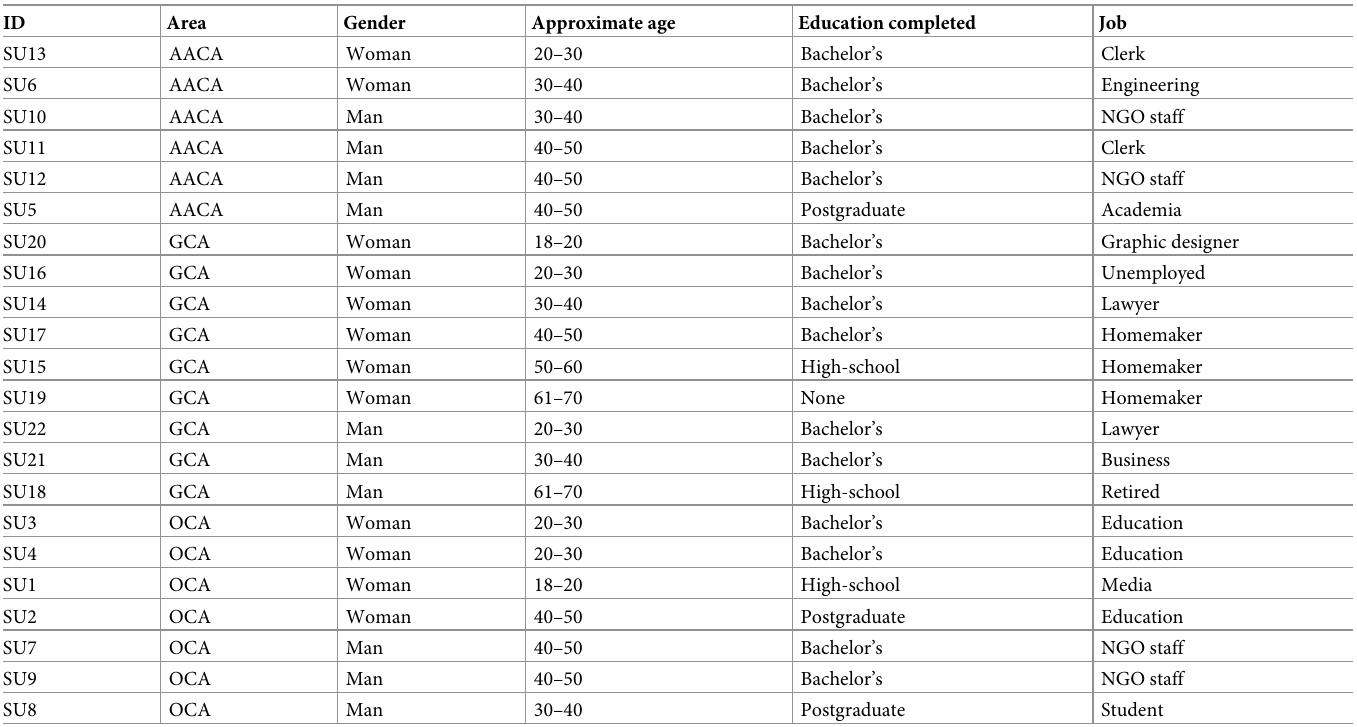
Table 1. Interviewee